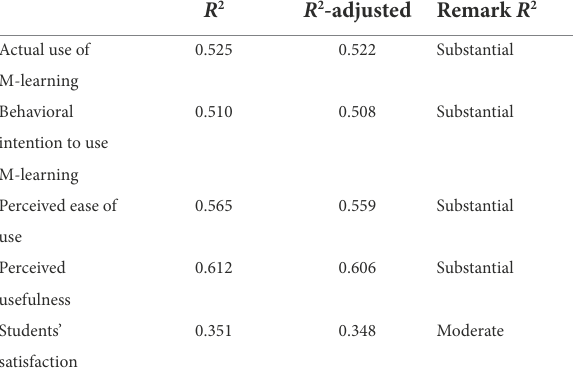
TABLE 6 Summary coefficient of determination, R 2 . R 2 R 2 - adjusted